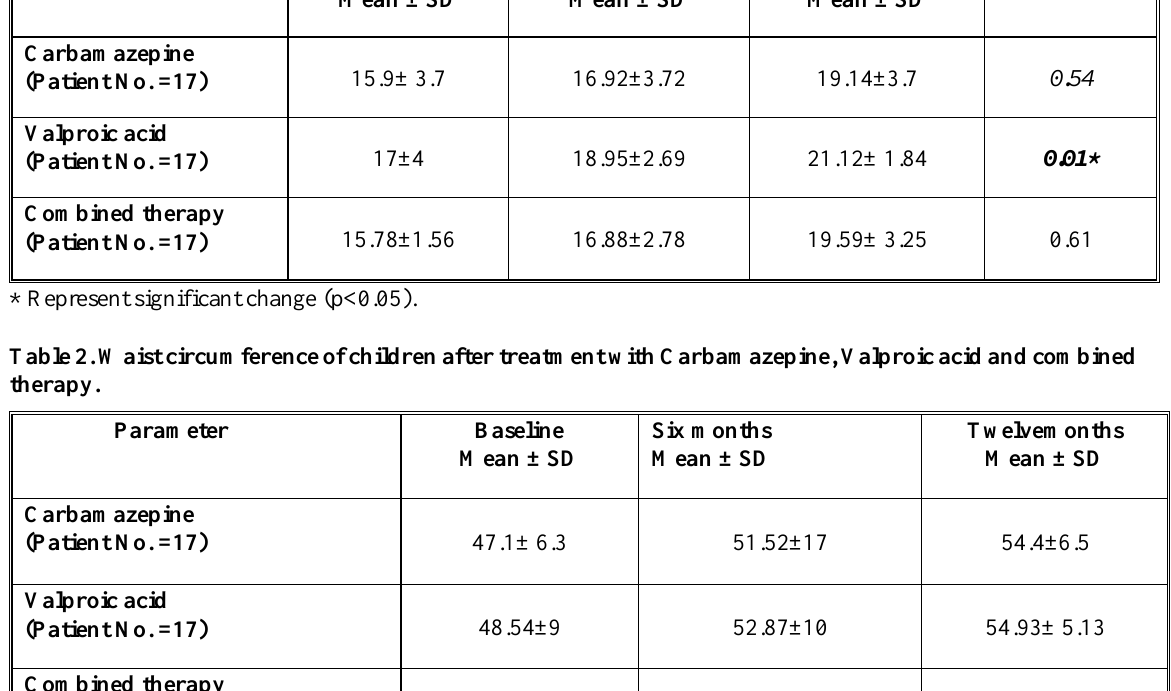
Table 1. BMI of children after treatment with Carbamazepine, Valproic acid and combined therapy. Parameter